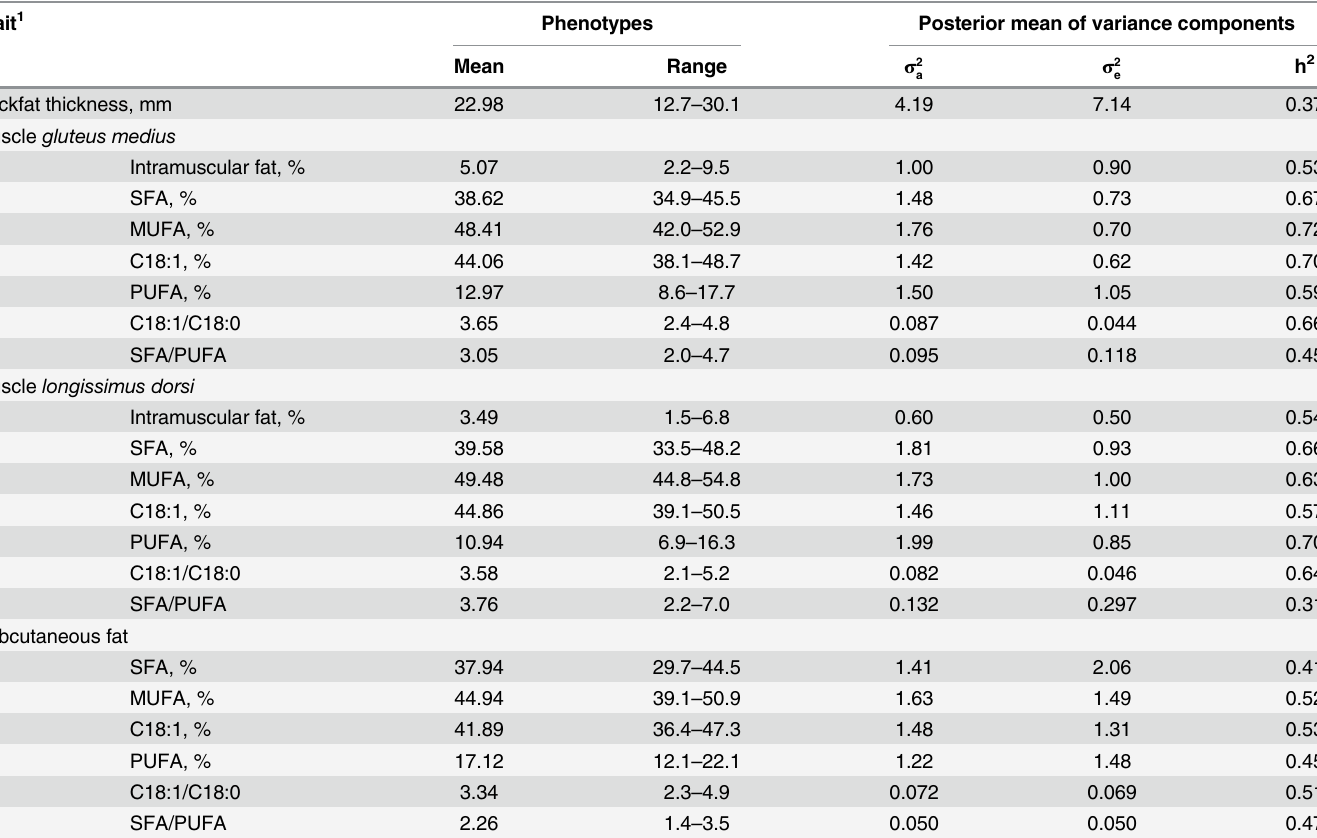
Table 1. Mean and range of phenotypic values and posterior means of marker-based additive genetic ( σ 2 a ) and residual ( σ 2 e ) variances and heritabil- ity (h 2 ). Trait 1